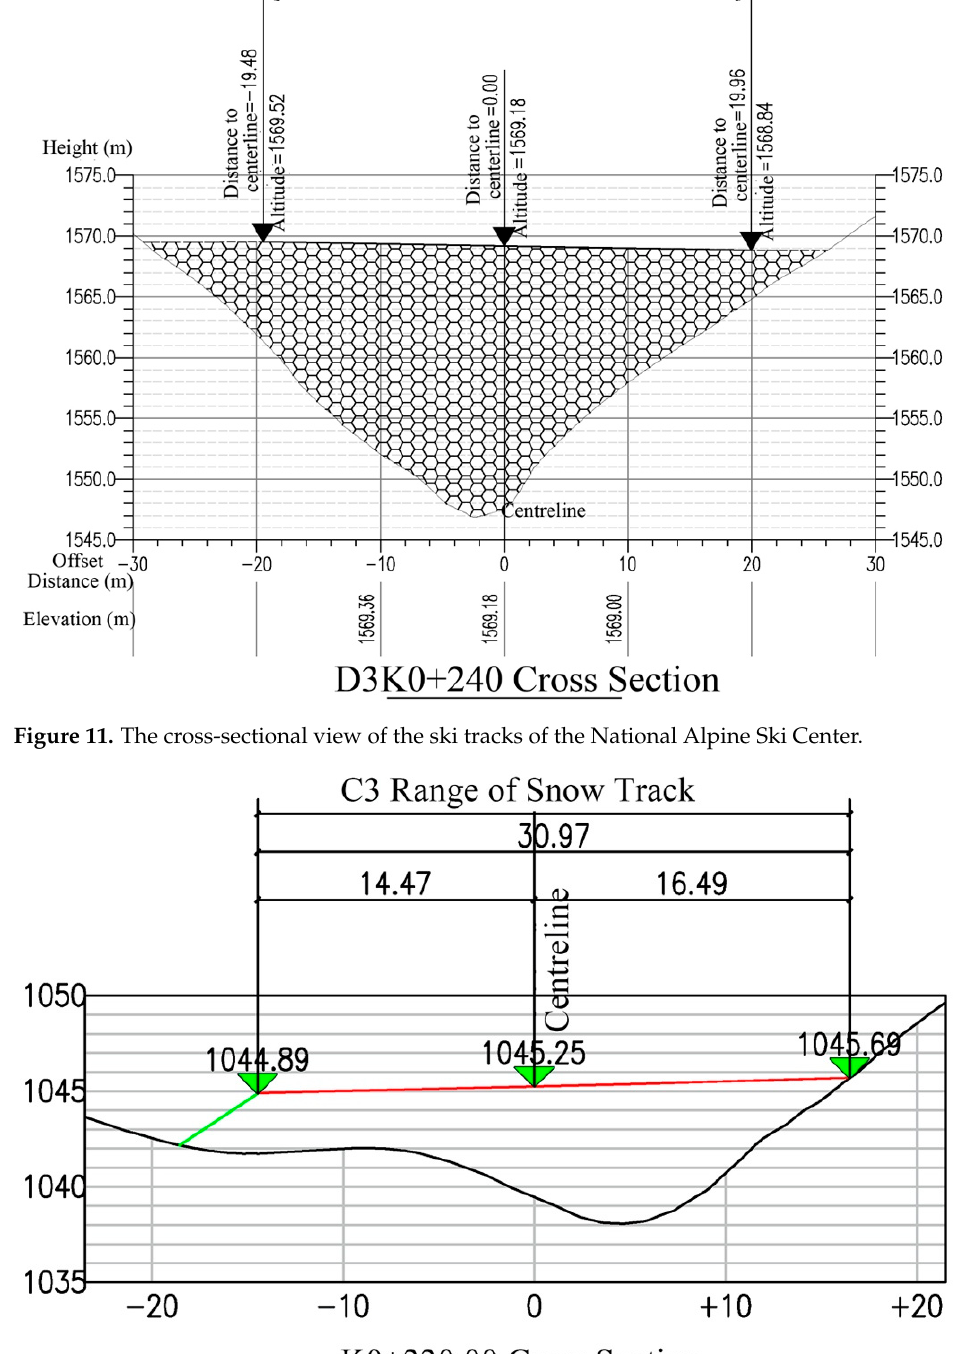
Figure 12. The cross-sectional view of the ski tracks of WTST.